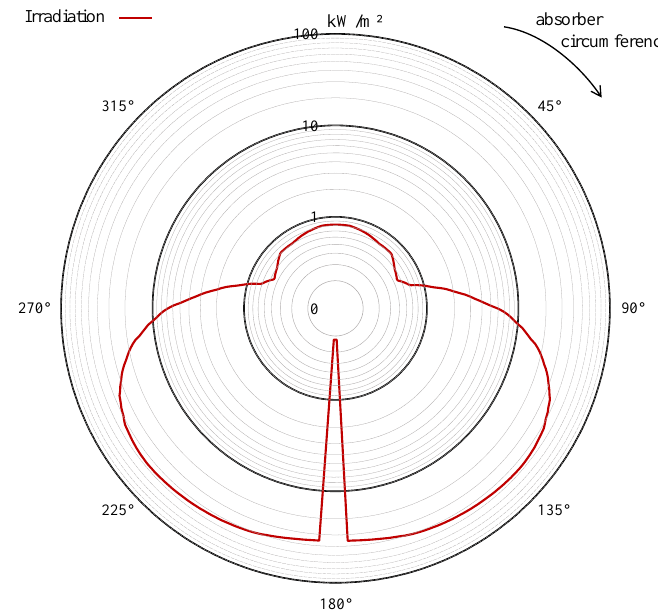
Figure 9. Polar plot of solar irradiation over the absorber circumference in log-scale. The solar collector causes high radiation fluxes from the bottom of the absorber while unconcentrated solar radiation is incident on the top of the